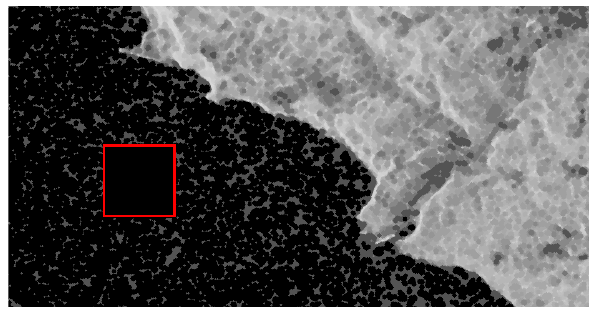
Figure 8. Eliminating remaining noise gray values.